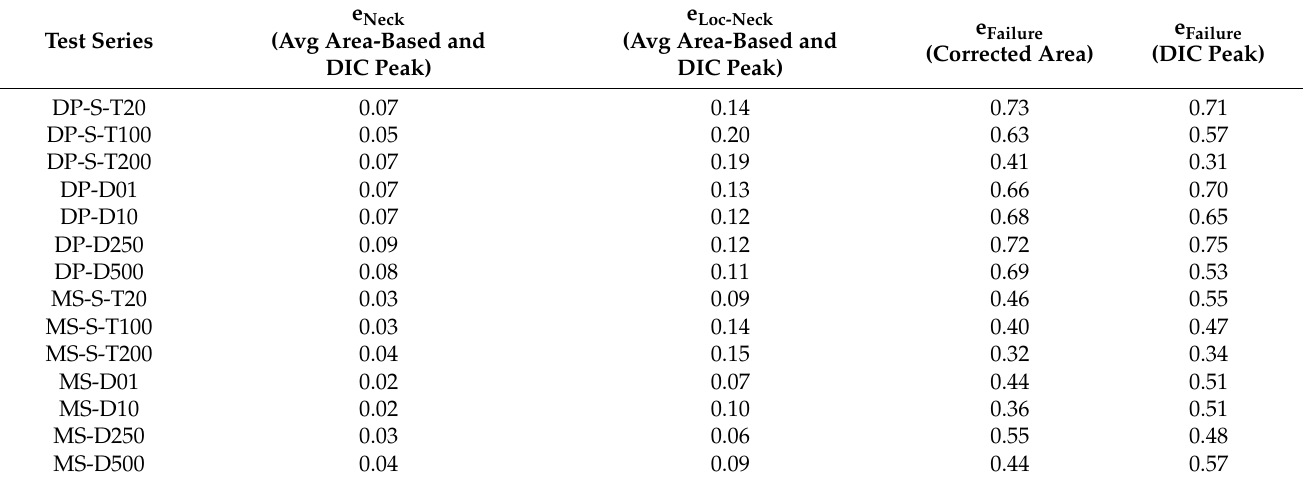
Figure 16. True curves from dynamic tests of the DP ( a ) and MS ( b ) materials. Table 4. Strains at necking onset and failure according to the area-based and DIC peak procedures.